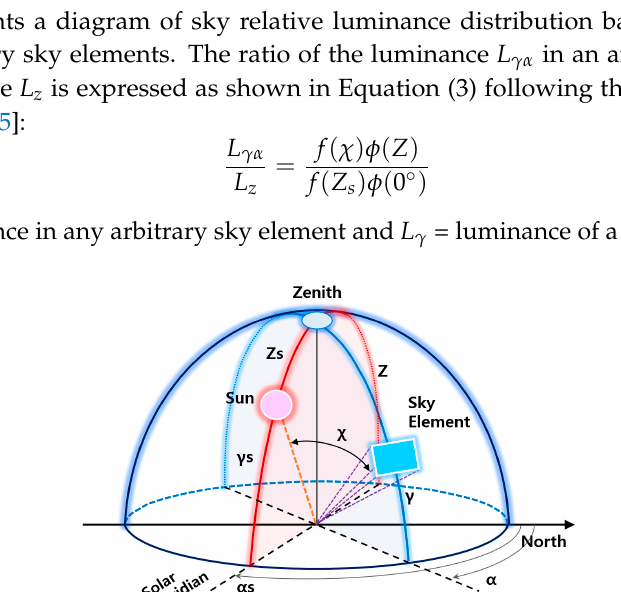
Table 1. CIE standard sky model’s parameters.